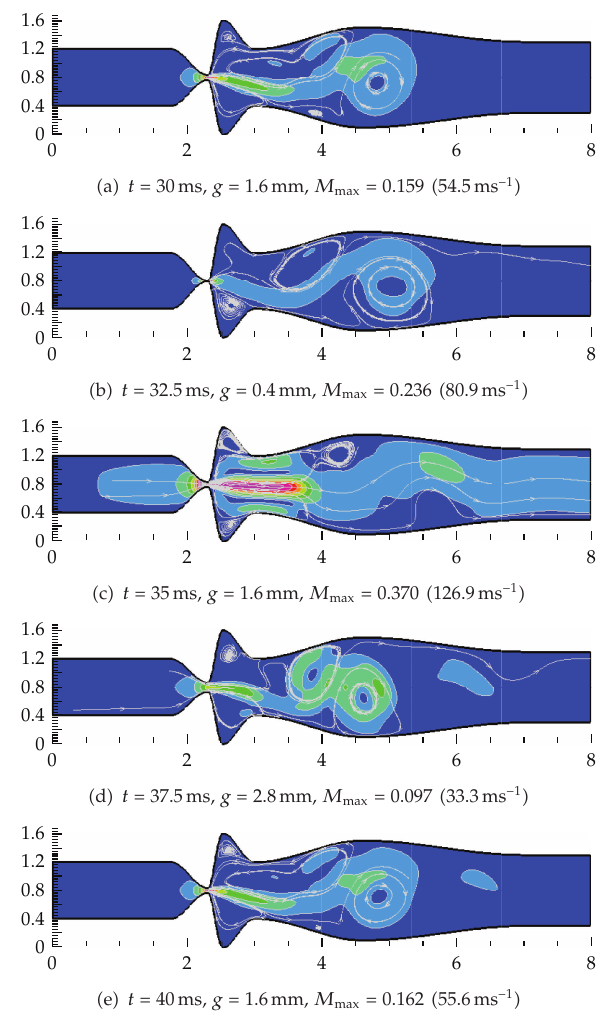
(cid:8) f (cid:4) 100Hz , M ∞ (cid:4) 0 . 012 , Re ∞ (cid:4) 4481 ,